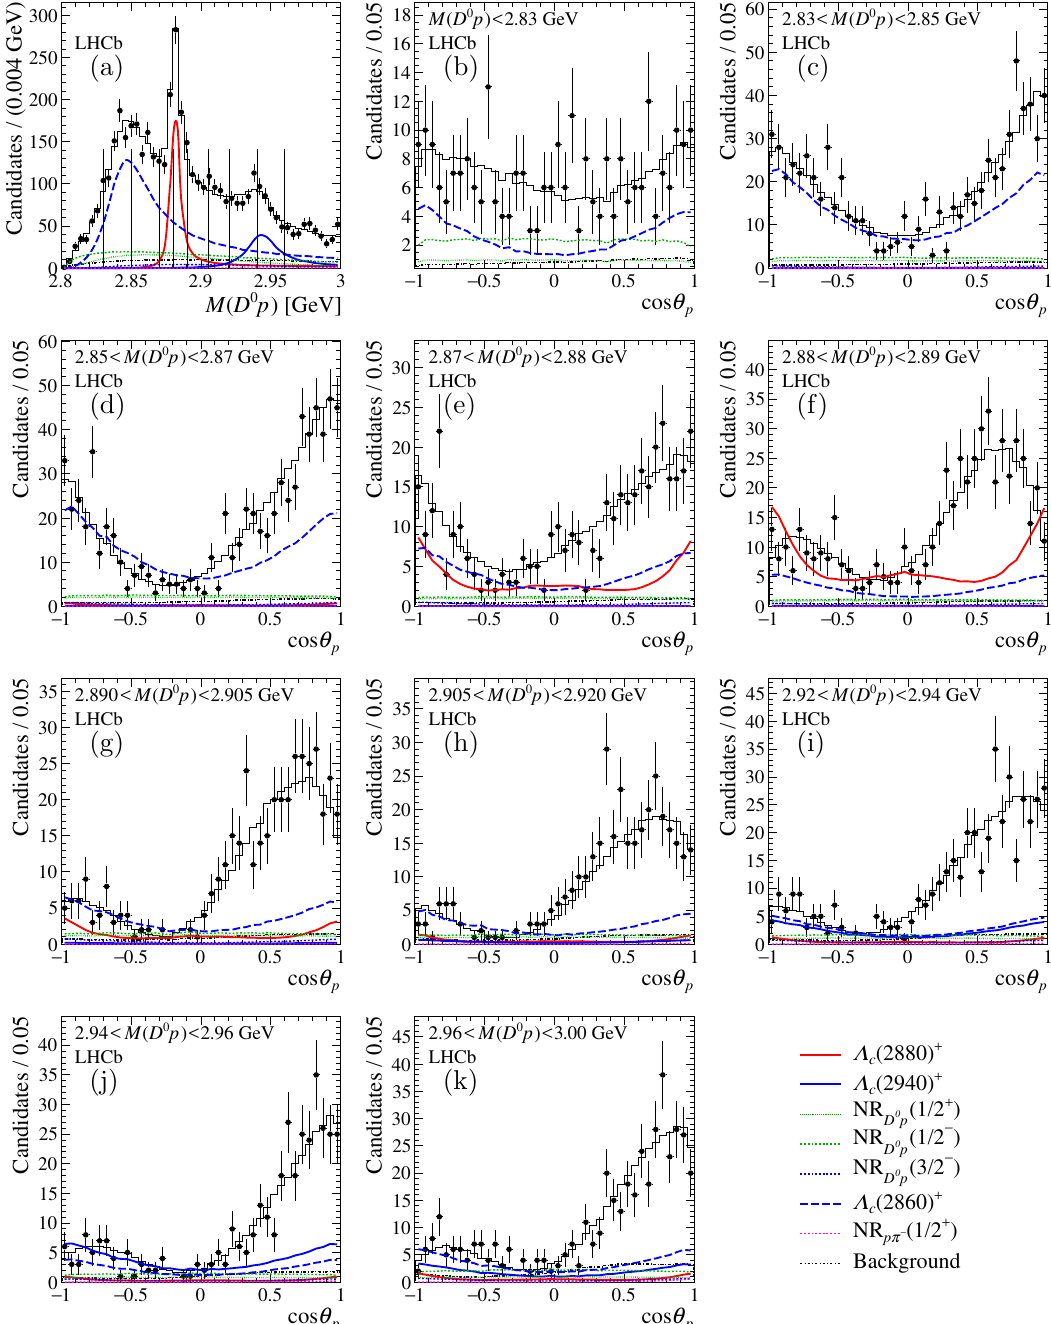
Figure 13 . Results of the (cid:12)t of the (cid:3) 0 ! D 0 p(cid:25) (cid:0) data in the D 0 p mass region including the b (cid:3) c (2880) + and (cid:3) c (2940) + resonances (region 4): (a) m ( D 0 p ) projection and (b{k) cos (cid:18) p projections for slices of D 0 p invariant mass. An exponential model is used for the nonresonant partial waves, and the J P = 3 = 2 (cid:0) hypothesis is used for the (cid:3) c (2940) + state. Vertical lines in (a) indicate the boundaries of the D 0 p invariant mass slices. Due to interference e(cid:11)ects the total is not necessarily equal to the sum of the